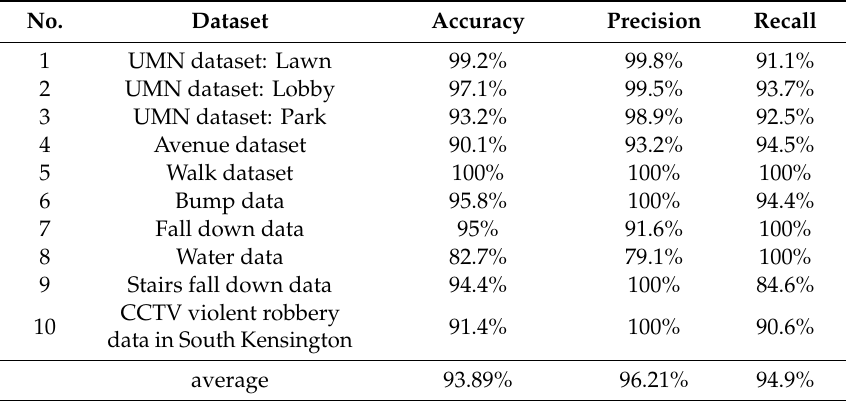
Table 4. The overall performance evaluation result of the proposed method.